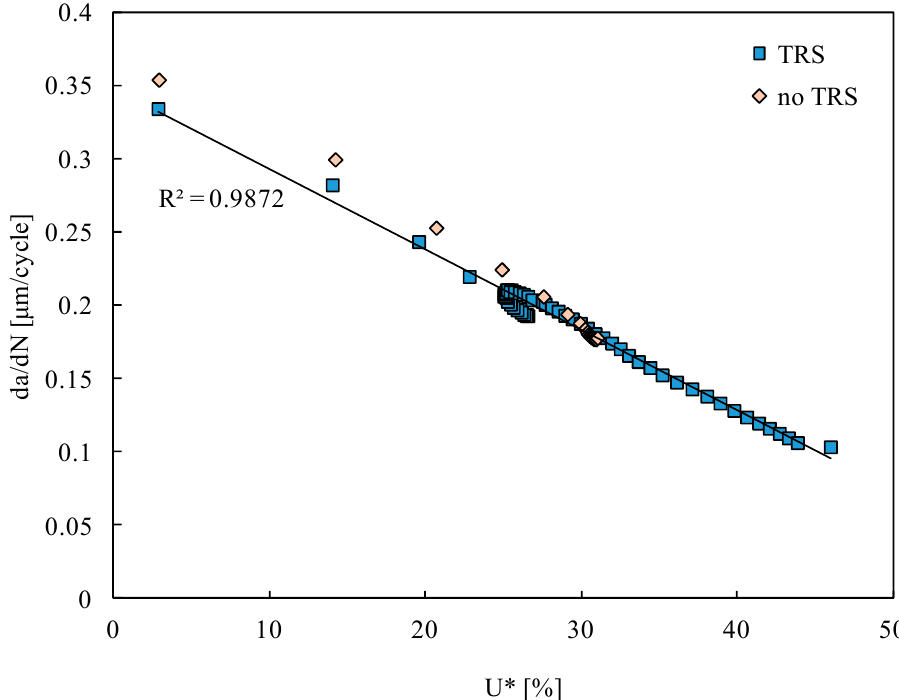
Figure 8. FCG rate versus crack closure level quantified by U* .